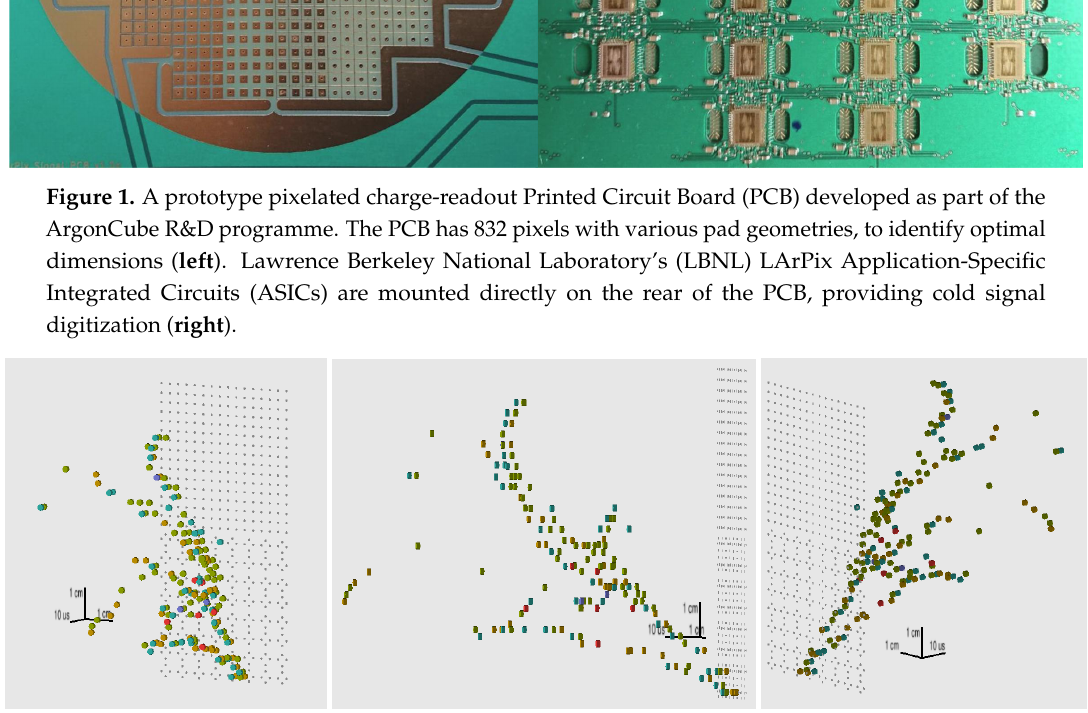
Figure 2. A cosmic ray-induced shower recorded with the LBNL LArPix equipped charge-readout system shown in Figure 1 in the Bern pixel demonstration LArTPC. The same 3D event is shown from three different